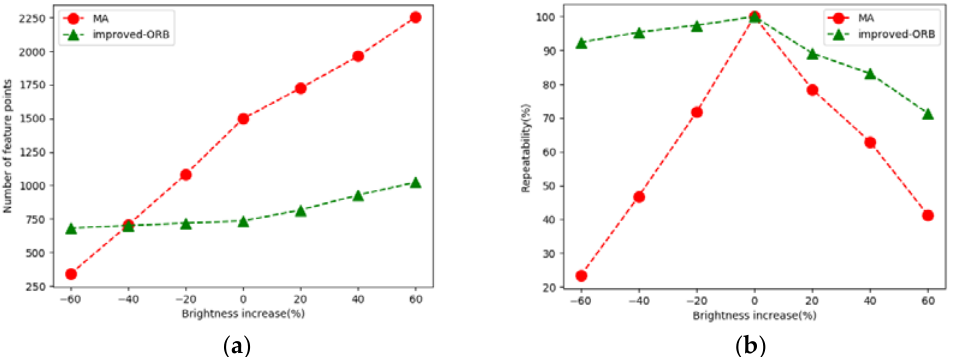
Figure 10. The performance of two algorithms in the case of changes in brightness. ( a , b ) They show the comparison of the number of point features and the feature repetition rates under different lighting conditions, respectively. The green lines show the advantages of the improved algorithm in this paper.